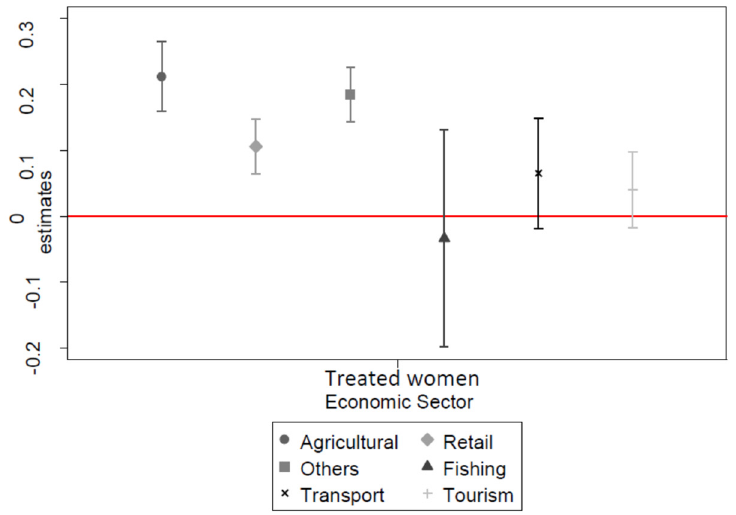
Figure 1. The Effect of CME on Loans Granted by Economic Sector (pp).